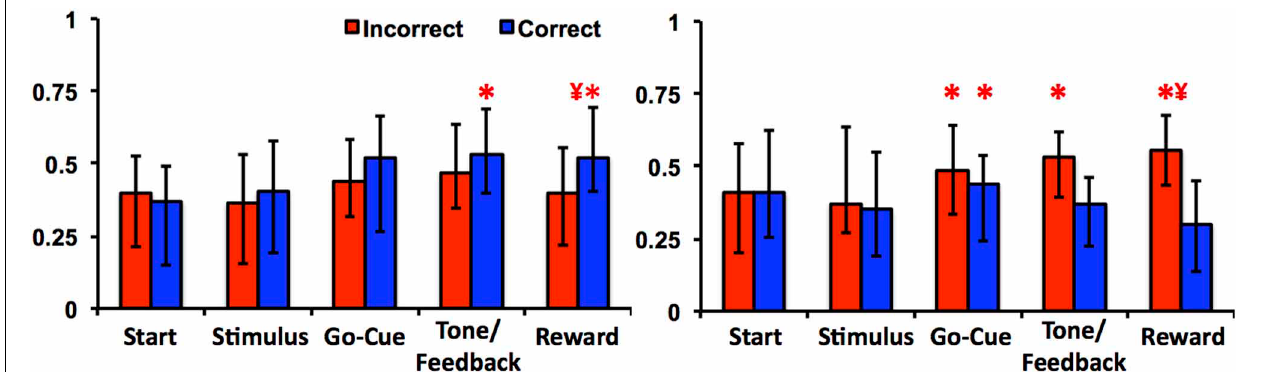
FIGURE 5 | Neuronal activities of Class I and Class II neurons during incorrect and correct novel object trials. The left panel illustrates the average firing rate (median ± quartiles; normalized spikes per second) of Class I neurons compared to baseline (mean firing rate at the start epoch) in incorrect (red) and correct (blue) trials. The right panel